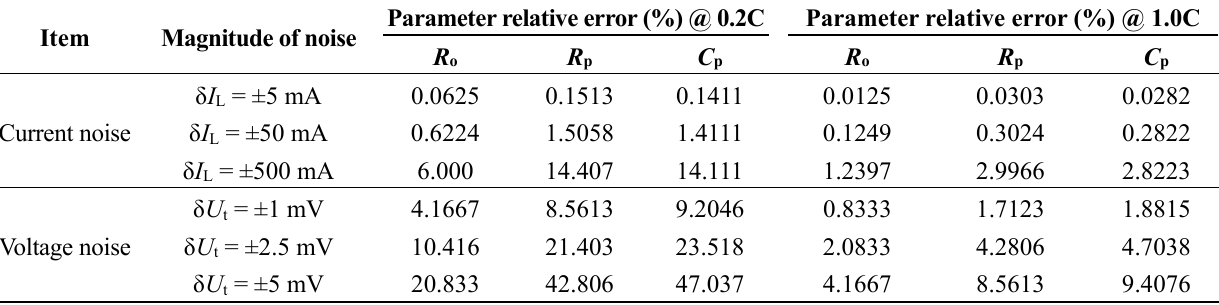
Table 2. Minimum values of relative error of model parameters ( R o , R p , C p ) under current/voltage noises.